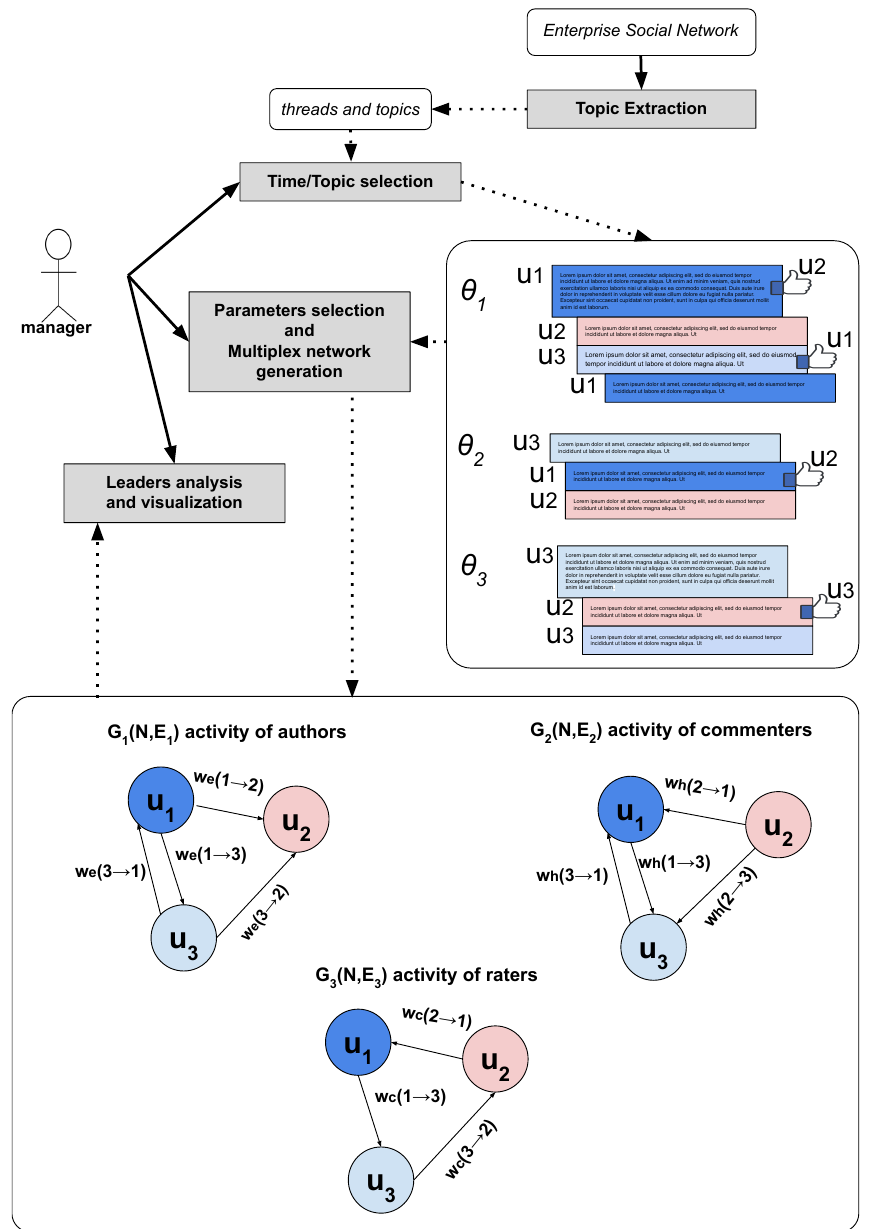
Figure 1. Use case of the ESAD. We represent the main functionalities of the proposed system. The small example of threads (upper right box) is based on a set of 3 users N = { u 1, u 2, u 3 } and three threads (i.e., θ 1 , θ 2 and θ 3 ). User u 1 is the author of θ 1 , and u 3 authored θ 2 and θ 3 . In θ 1 , u 2 and u 3 replied to u 1, and u 1 replied to u 3; the user u 2 liked the post of u 1, and u 1 liked the reply of user u 3. In θ 2 , u 1 and u 2 replied to u 3, and user u 2 liked the reply of u 1; and, finally, in θ 3 , u 2 replied to u 1, and the user u 3 liked the reply of u 2 and posted a reply to u 2. The corresponding multiplex network (see box at the bottom) is composed by three layers, i.e., G 1 , G 2 , and G 3 , where nodes are users and weighted directed edges represent the activities of authors, commenters, and raters,